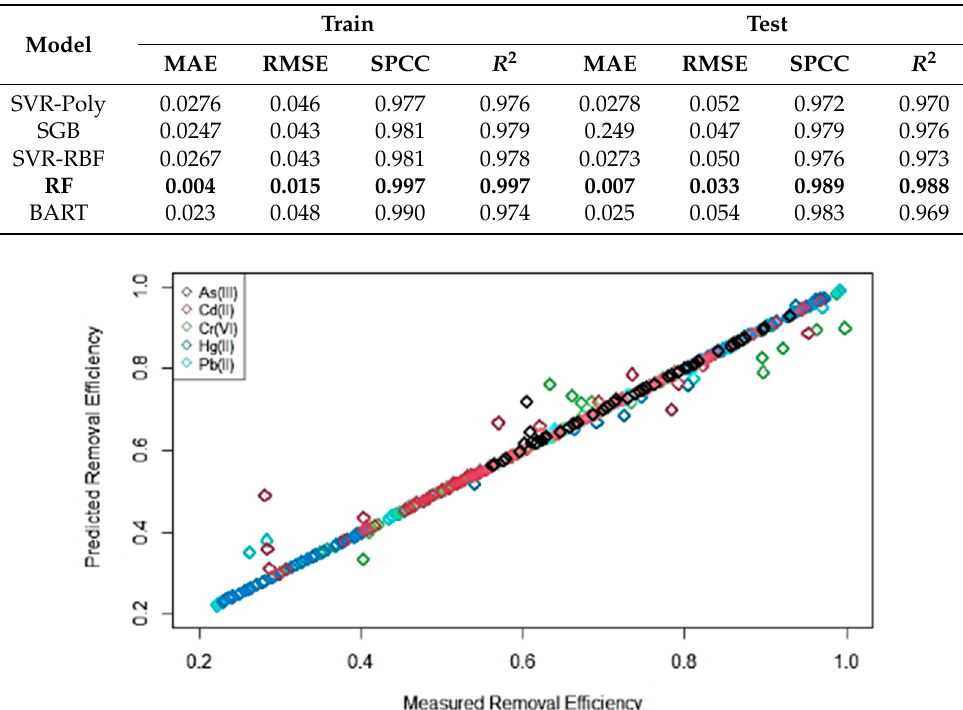
Figure 4. The percentage residual error plot for the generalized RF model estimated removal efficiency for the independent test data. 4. Discussion The current study presents a comprehensive approach to modeling adsorption efficiency. A wide range of ML models was applied to model the experimental adsorption of five toxic heavy metals with ten different adsorbents. As the modeling of an adsorption process involves non-linear feature interactions, the utility of the non-linear parametric regression models, such as SVR with polynomial and RBF kernels, RF, and SGB, including a Bayesian regression approach called BART, were examined in the current study. The RF and SGB were selected as the bagging and boosting algorithms, respectively. Both RBF and polynomial kernels in the SVR algorithm perform mapping of the input space to higher dimensional feature space, and, subsequently, the data points become linearly separable into that higher feature dimension. Similarly, three different variations of regression trees used in the current study are suitable for non-linear regression tasks. For each toxic metal, two datasets using two different adsorbents were considered, resulting in a total of 10 datasets